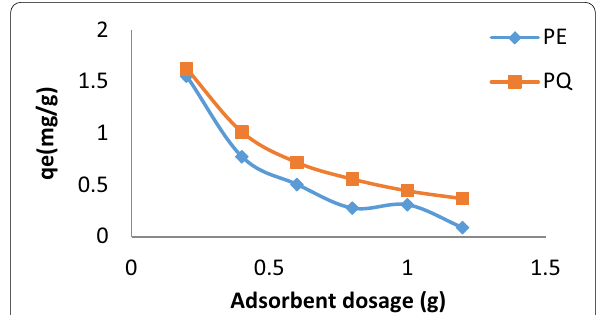
Fig. 5 Effect of adsorbent dosage on adsorption of ACBGNS onto PE and PQ , ( adsorption conditions: concentration of PE and PQ 50 mg/l, t 2 h, T 25 °C, m varied, volume of = = = = solution 10 cm 3 , agitation speed 150 rmp) = =